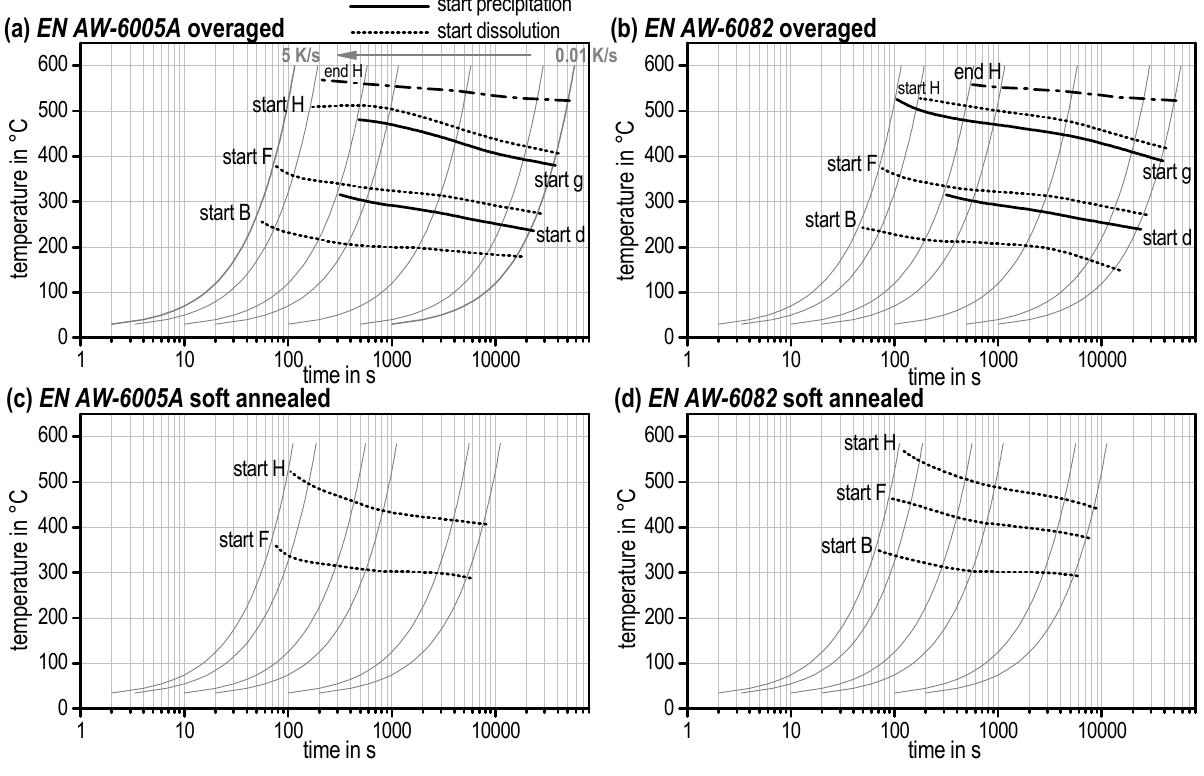
Figure 12. Continuous heating dissolution diagrams for ( a ) EN AW-6005A overaged; ( b ) EN AW-6082 overaged; ( c ) EN AW-6005A soft annealed; ( d ) EN AW-6082 soft